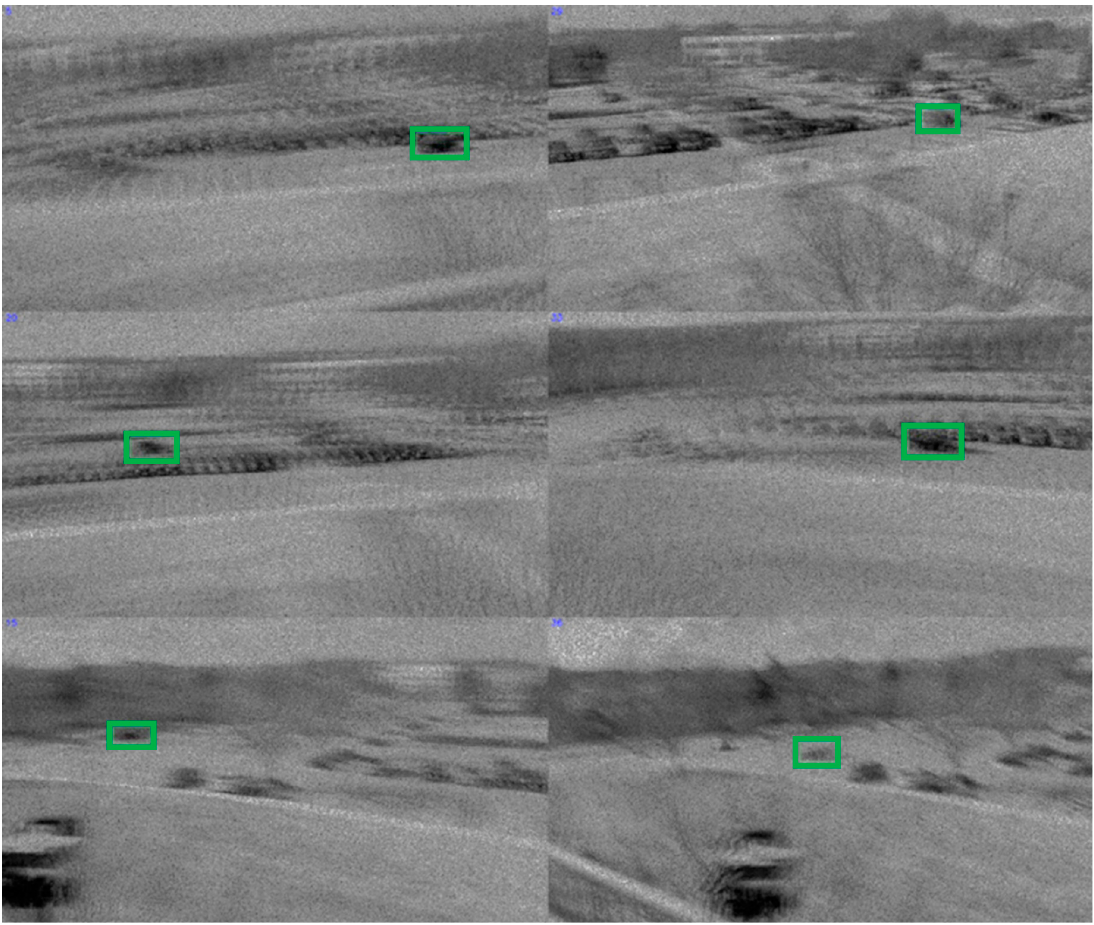
Figure A2. IMG429 50 percent missing tiled image results. Bounding box detections outlined in green. Experiment for IMG430 video: Table A3. Confusion matrix for the IMG430: 0% missing pixels trial with YOLO classification.